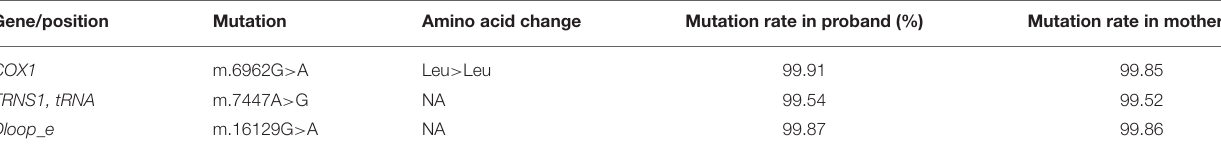
TABLE 1 | The three mitochondrial DNA mutations identified in proband and her mother. Gene/position Mutation Amino acid change Mutation rate in proband (%) Mutation rate in mother